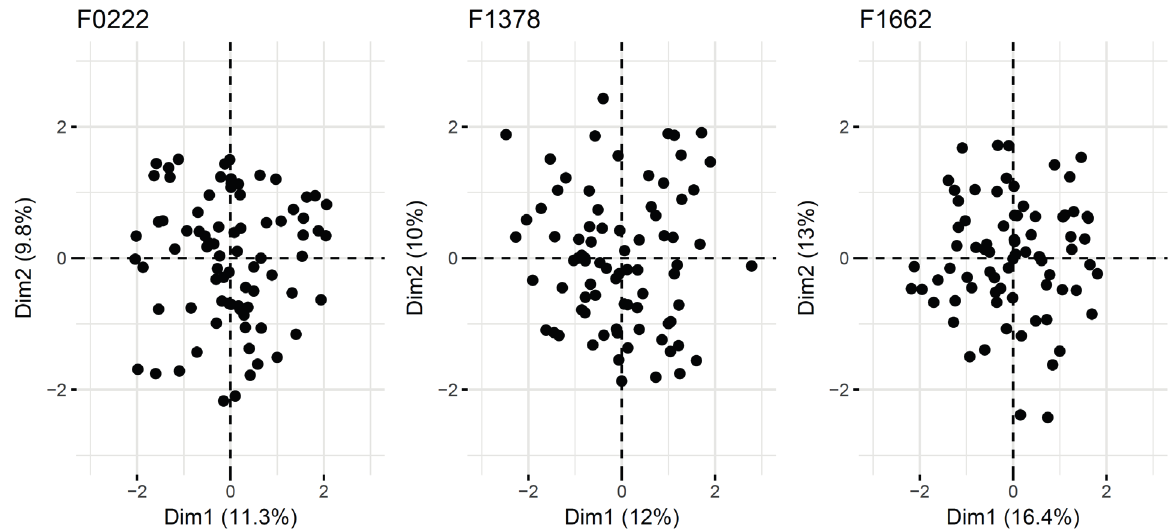
progenies derived from parent BGM0222 (F0222), BGM1378 (F1378), 1